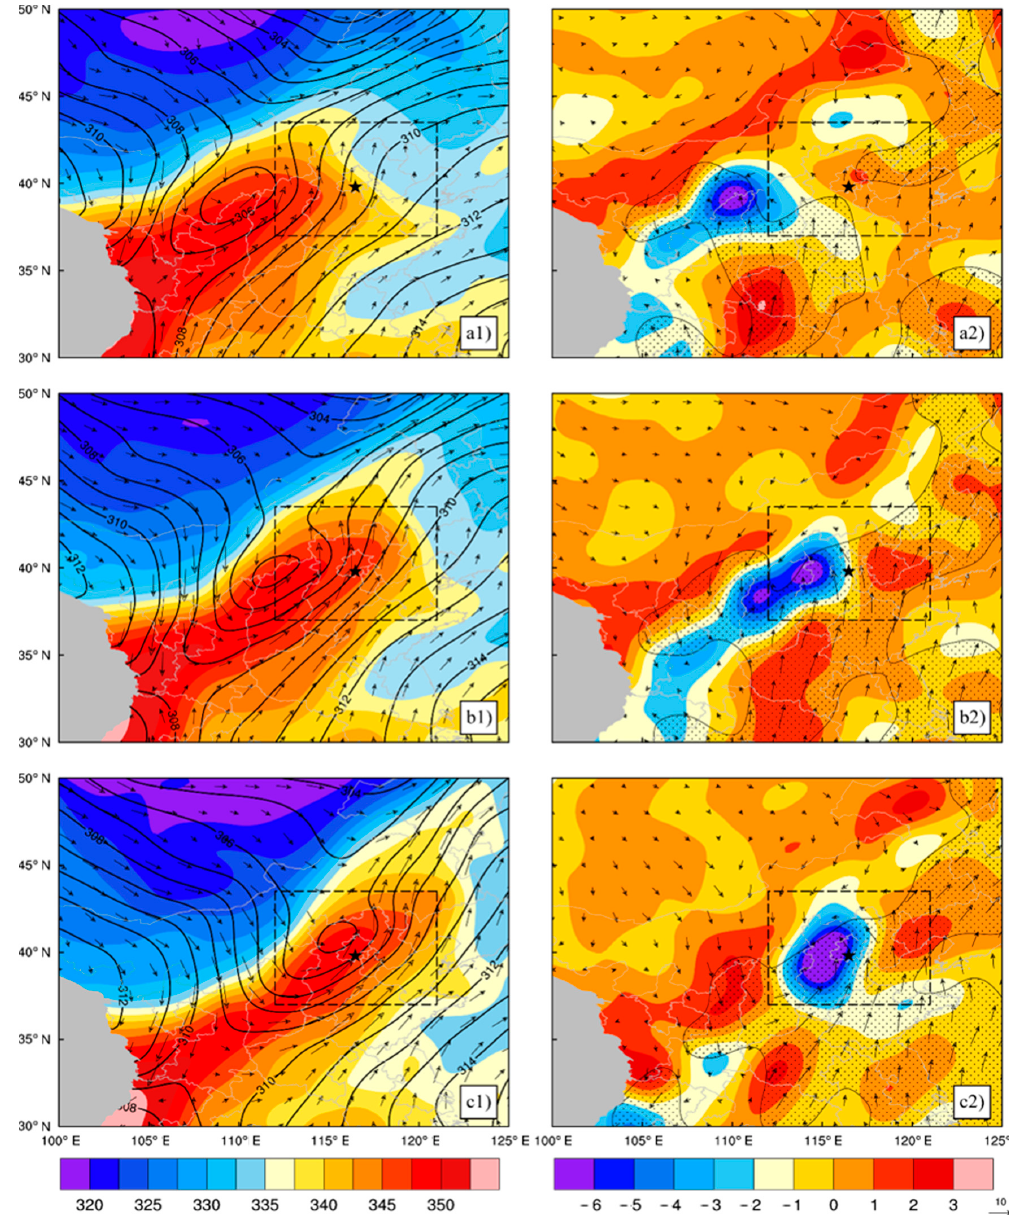
Figure 2. ( a1 – c1 ) Observed equivalent temperature (shaded, units: K), geopotential height (contours, units: 10 gpm), and wind field (vector arrows, units: m s − 1 ) at 700 hPa. ( a2 – c2 ) Observed water vapor flux divergence (shaded, units: g (s·cm − 2 ·hPa − 1 ) − 1 ), water vapor flux (dotted, units: g s − 1 hPa − 1 cm − 1 ), and wind field (vector arrows, units: m s − 1 ) at 850 hPa. The positive (negative) value of water vapor flux divergence means the divergence (convergence) of water vapor. The results are valid at 0000 UTC ( a1 , a2 ), 0600 UTC ( b1 , b2 ), and 1200 UTC ( c1 , c2 ) 21 July 2012. The location of Beijing is marked with the black pentagram. The black dotted box denotes the area of domain 2.